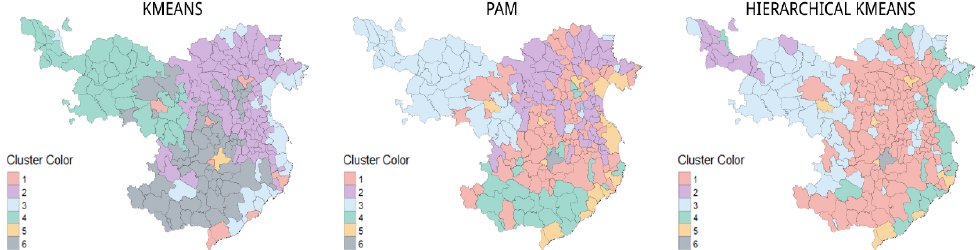
Figure 5. Representation of the cluster map: k-means, PAM and hierarchical k-means, according to the normal dataset, to observe their spatial distribution. Source: authors’ own elaboration.